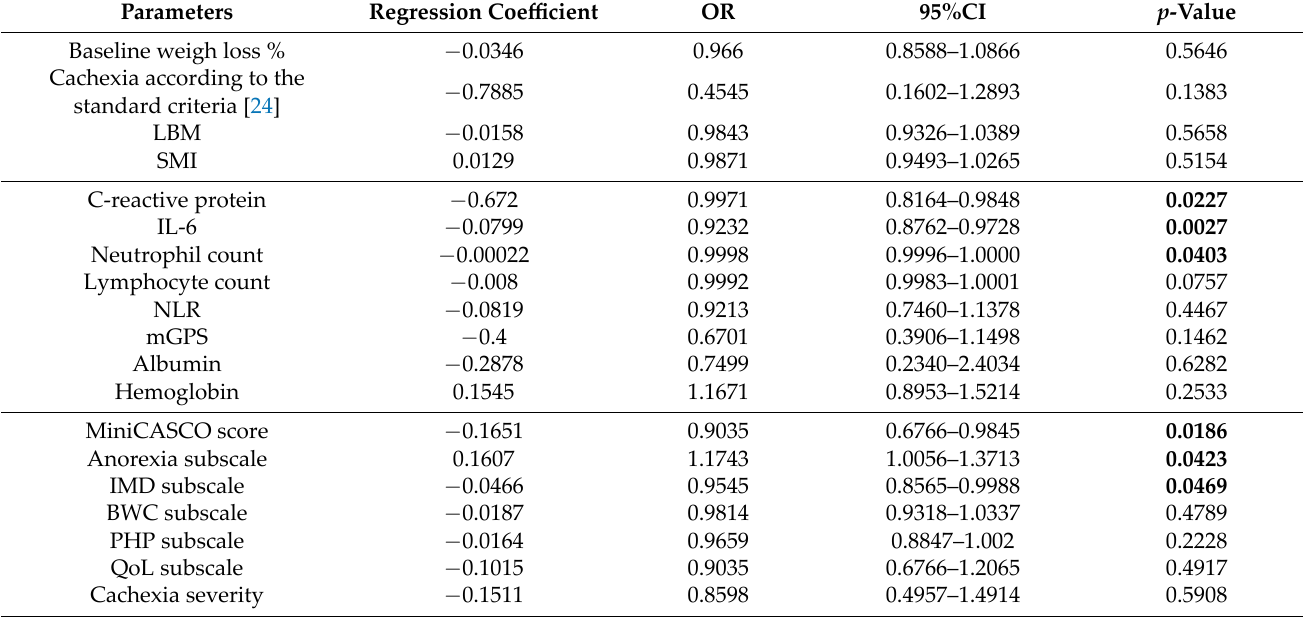
Logistic regression analysis between the parameters of cachexia, body composi‑ tion/nutritional status, inflammatory status, and miniCASCO and the clinical response (disease con‑ trol versus progressive